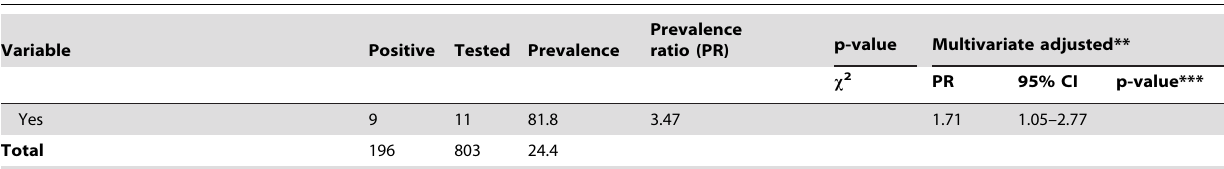
Table 2. Seizure frequency by distance to the nearest tapeworm carrier, Tumbes - Peru, 1999.